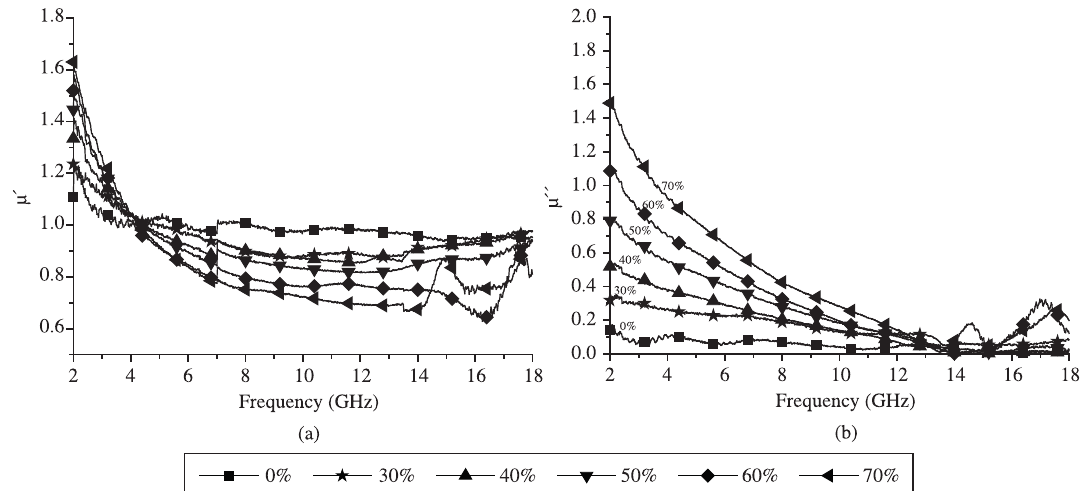
Figure 5. (a) Real and (b) imaginary magnetic permeability curves for RAM based on MnZn ferrite (0, 30, 40, 50, 60 and 70% (w/w)) in function of the